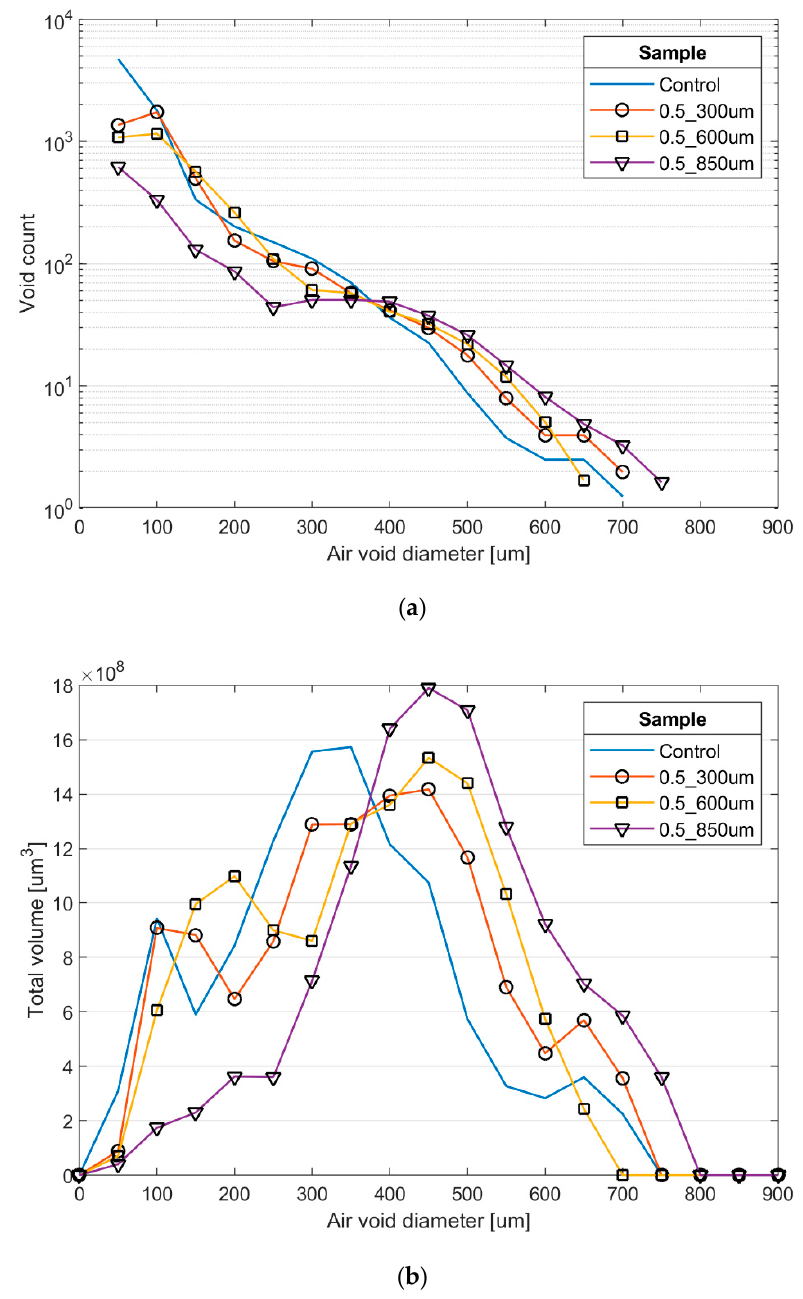
Figure 5. Statistics of the void ( a ) population and ( b ) volume distribution of the micro-CT specimens. These results have been normalized by a unit volume of 2500 × 2500 × 2500 µm 3 .